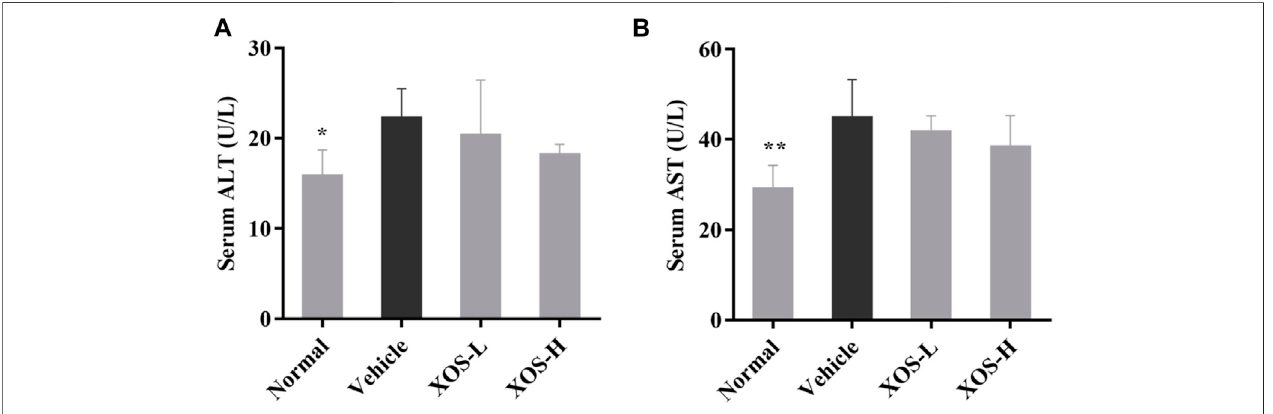
FIGURE 2 | Effect of XOS supplementation on (A) serum ALT level; (B) serum AST level. XOS-L: mice treat with XOS 250 mg/kg, XOS-H: mice treat with XOS 500 mg/kg. * p < 0.05, ** p < 0.01 compared with the Vehicle group.